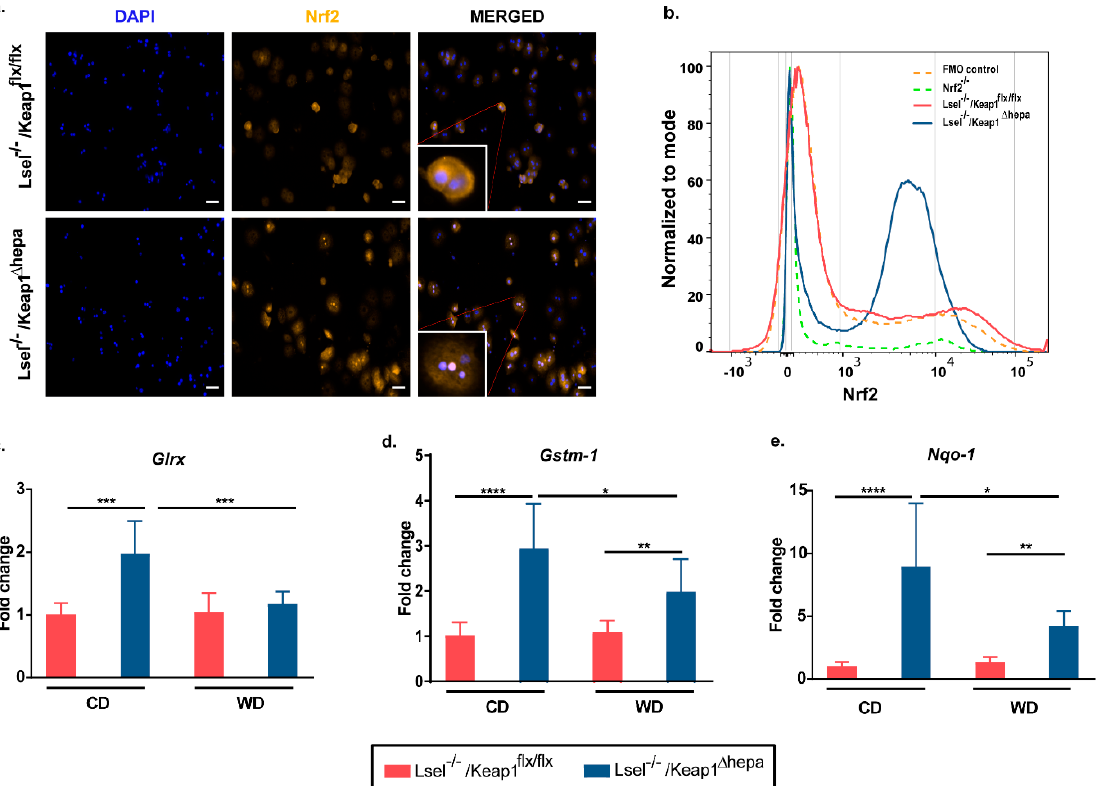
Figure 1. Lsel − / − Keap1 Δ hepa mice exhibit increased Nrf2 expression and an upregulation of Nrf2 target genes in the liver. ( a ) Representative immunofluorescence staining images indicate nuclear translocation of Nrf2 in hepatocytes of Lsel − / − Keap1 Δ hepa mice. Hepatocytes of untreated mice were labeled with anti-Nrf2 (orange) and DAPI (blue). Scale bar: 50 µm. ( b ) Representative flow cytometric analysis indicates increased Nrf2 in hepatocytes of Lsel − / − Keap1 Δ hepa mice. (c-e) Levels of the mRNAs indicated were measured in liver tissue of Lsel − / − Keap1 flx/flx mice (red bars) and Lsel − / − Keap1 Δ hepa mice (blue bars) after 24 weeks of feeding with chow diet (CD) or Western diet (WD). mRNA levels are expressed as fold increase over the mean value obtained for healthy control liver tissue from Lsel − / − Keap1 flx/flx mice. (Lsel − / − Keap1 flx/flx CD-fed (n = 6), Lsel − / − Keap1 flx/flx WD-fed (n = 12), Lsel − / − Keap1 Δ hepa CD-fed (n = 4), Lsel − / − Keap1 Δ hepa WD-fed (n = 8). ( c ) Glrx (glutaredoxin) , ( d ) Gstm-1 ( glutathion S-transferase1 )( e ) Nqo-1 (NAD(P)H quinone dehydrogenase 1) Statistical significance was calculated by the one-way ANOVA (analysis of variance). Values are represented as mean ± SD. * p ≤ 0.05, ** p ≤ 0.01, *** p ≤ 0.001, **** p ≤ 0.0001.